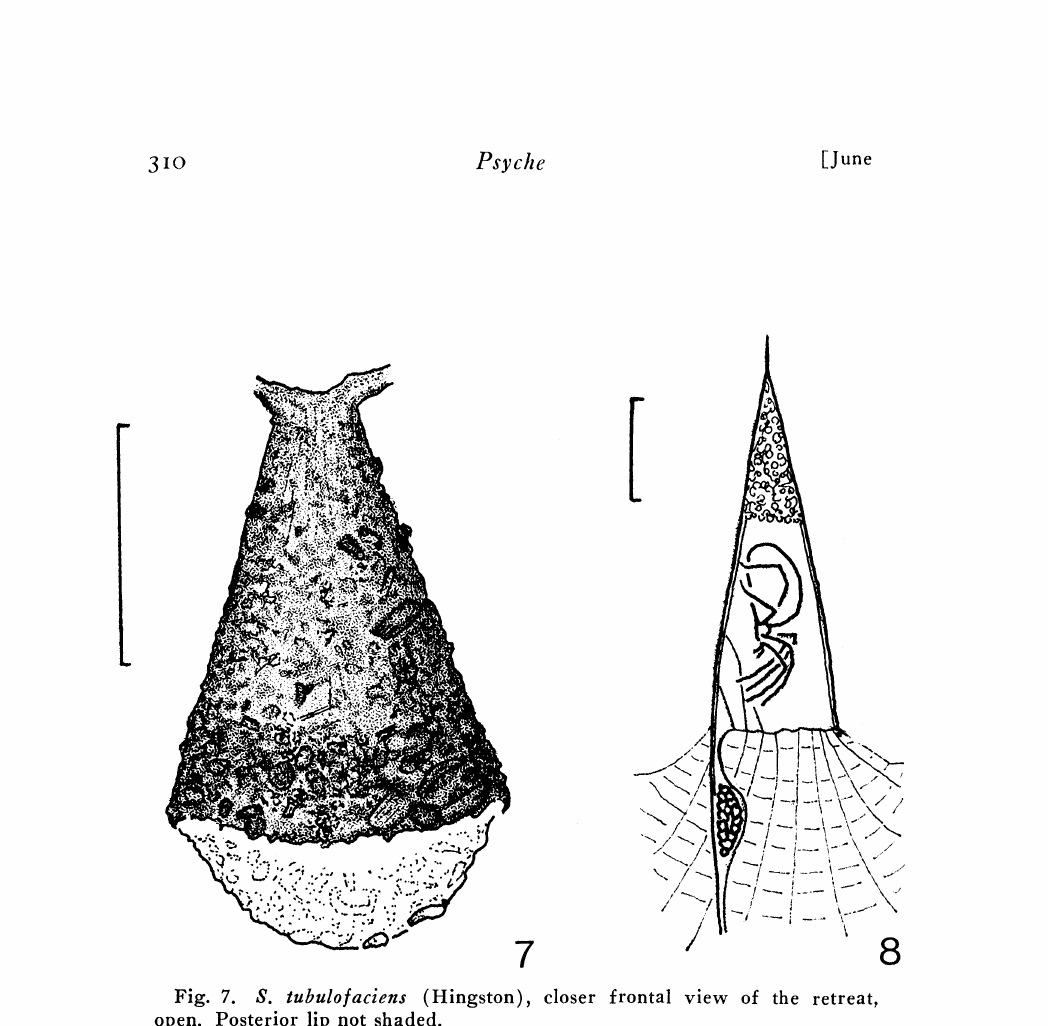
Fig. 7. S. tubulo[aciens (Hingston), closer frontal view of the retreat, open. Posterior lip not shaded. Fig. 8. S. arti[ex Simon, schematic representation of a cross section of the retreat. Posterior lip of the retreat hangs loose, enclosing mass of eggs (Modified from Simon, 1896, pl. 12, fig 4). Size indicators: Figs. 7-8,